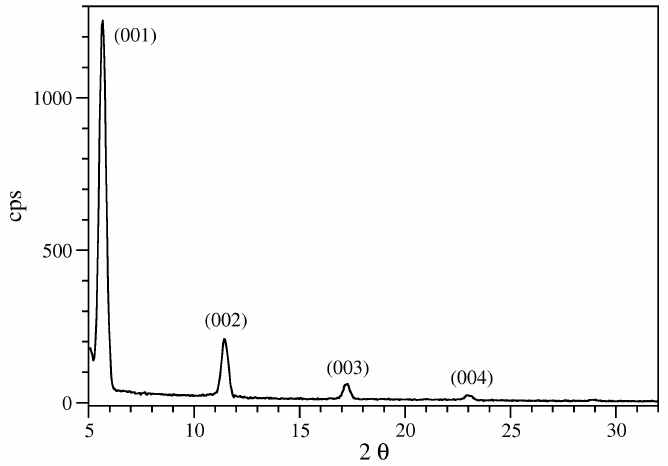
Figure 4. Grazing angle X-ray diffraction pattern for a ≈ 18 ML pentacene